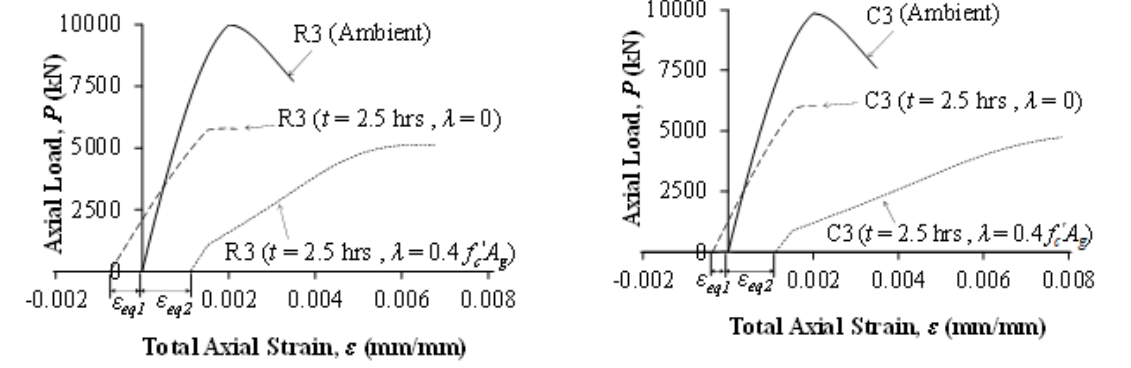
Figure 10. Influence of initial load level on the residual ( P - ε ) relationship.